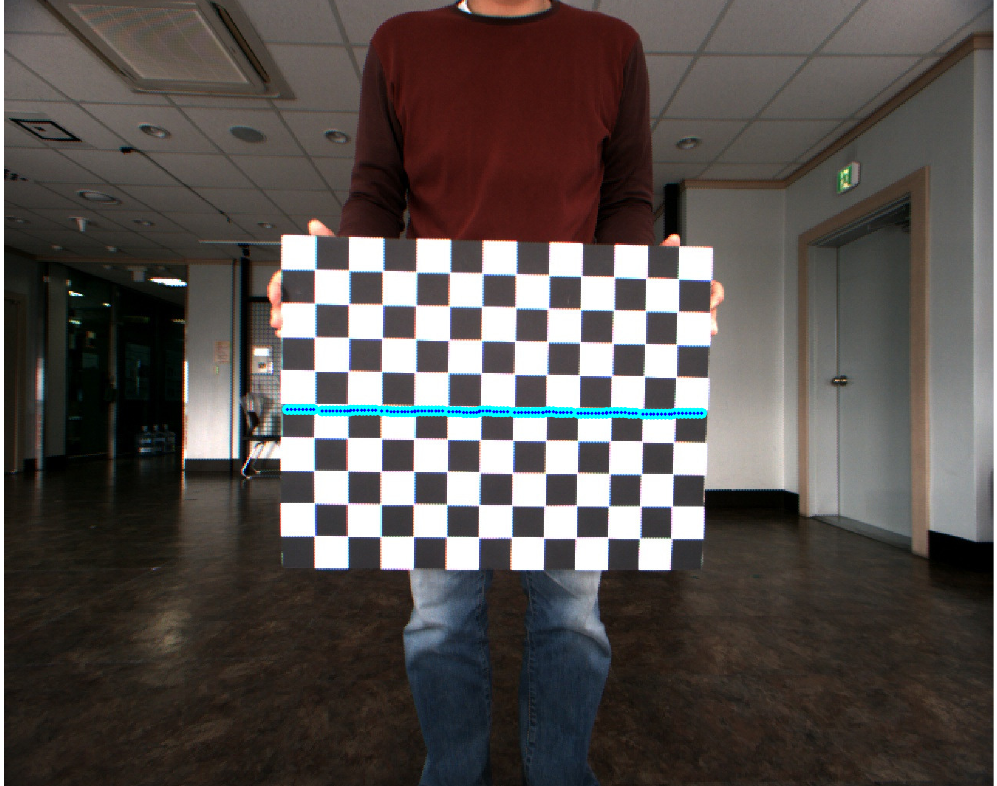
Figure 9. Projection of the laser scanner’s depth data to the checker board